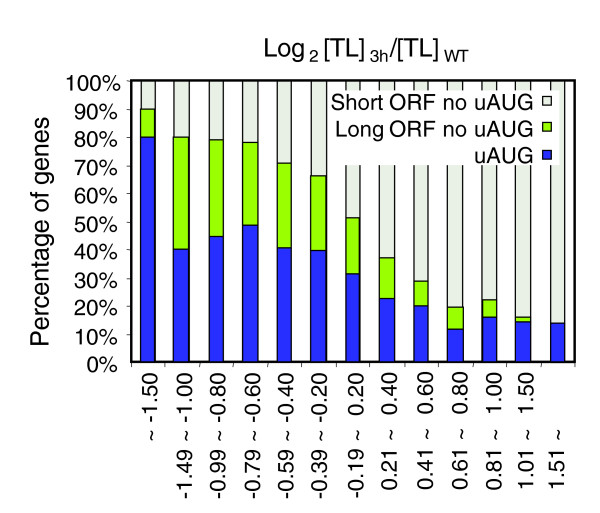
Contribution of the length of the main ORF versus the presence of uORFs to the translation state of mRNAs. Bins selected according to the extent of eIF3h-dependence (Figure 7) were examined for the percentage of genes with a long (> 1,300 nt) main ORF but no uAUG, a short main ORF (< 1,300 nt) and no uAUG, and any number of uAUGs.